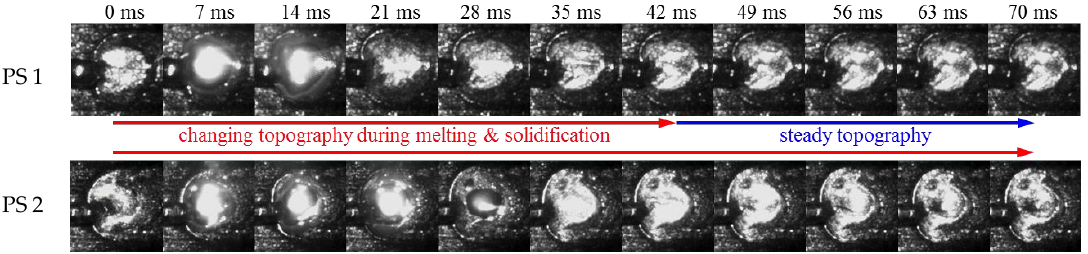
Figure 19. Melting and solidification process for pulse shape 1 and 2 during one periodic time, both for 1000 W pulse peak power, 4 mm/s wire-feeding rate and without hot-wire application.